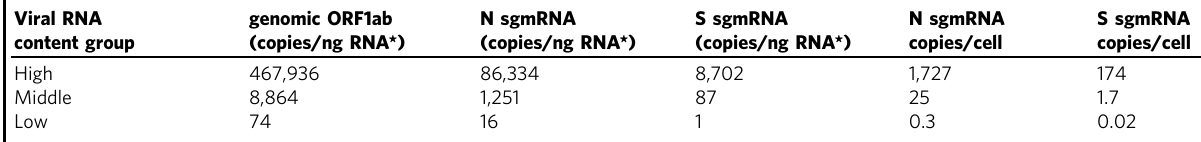
Table 3 N and S sgmRNA molecules number per cell according to the viral RNA content group. Viral RNA content group